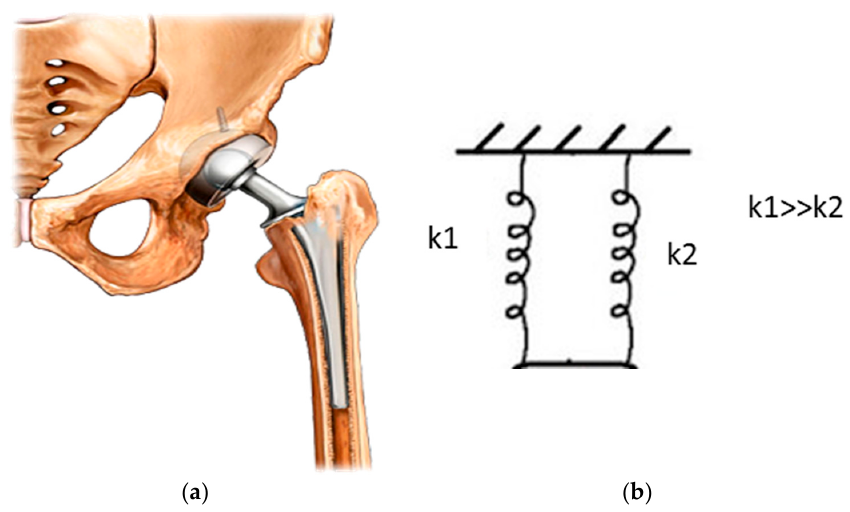
Figure 1. ( a ) Total hip joint representation and ( b ) schematic view of two springs in parallel, where k 1 and k 2 are implant and bone stiffness, respectively. (From [35]).